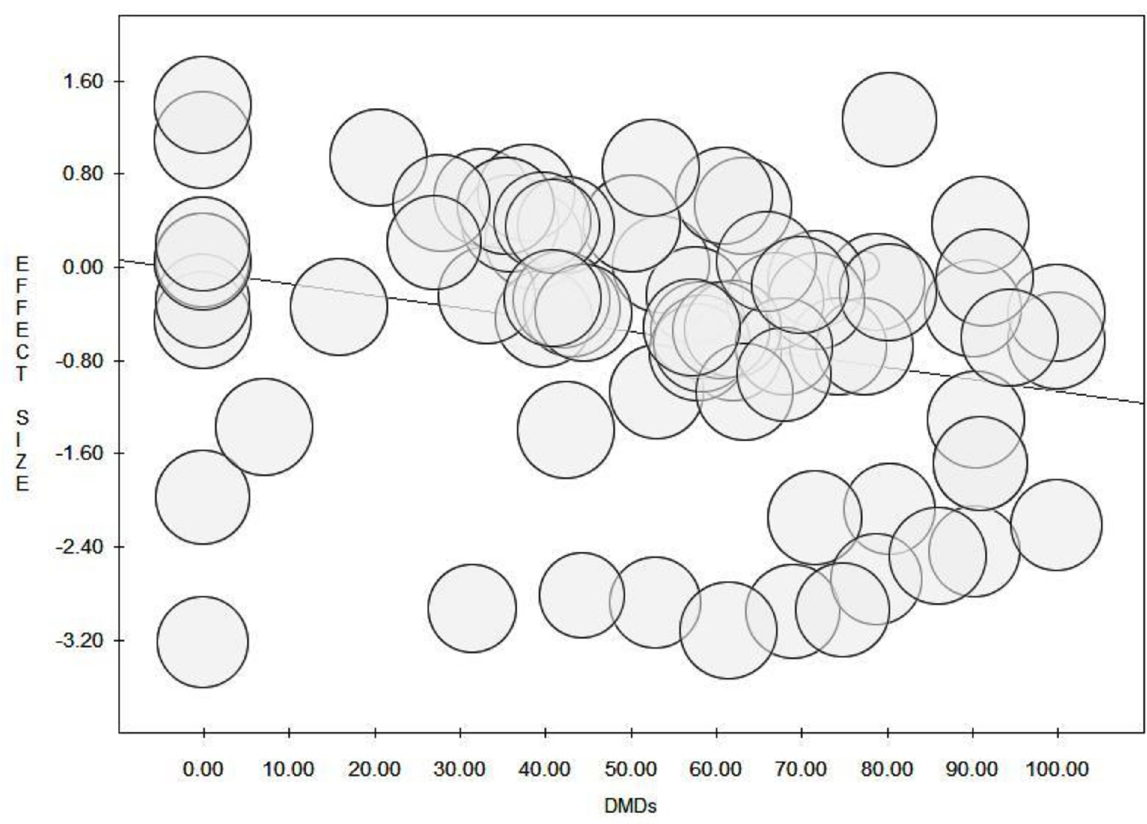
Fig 3. Meta-regression (random-effects model) of the prevalence of unemployment according to the use of DMDs (%).